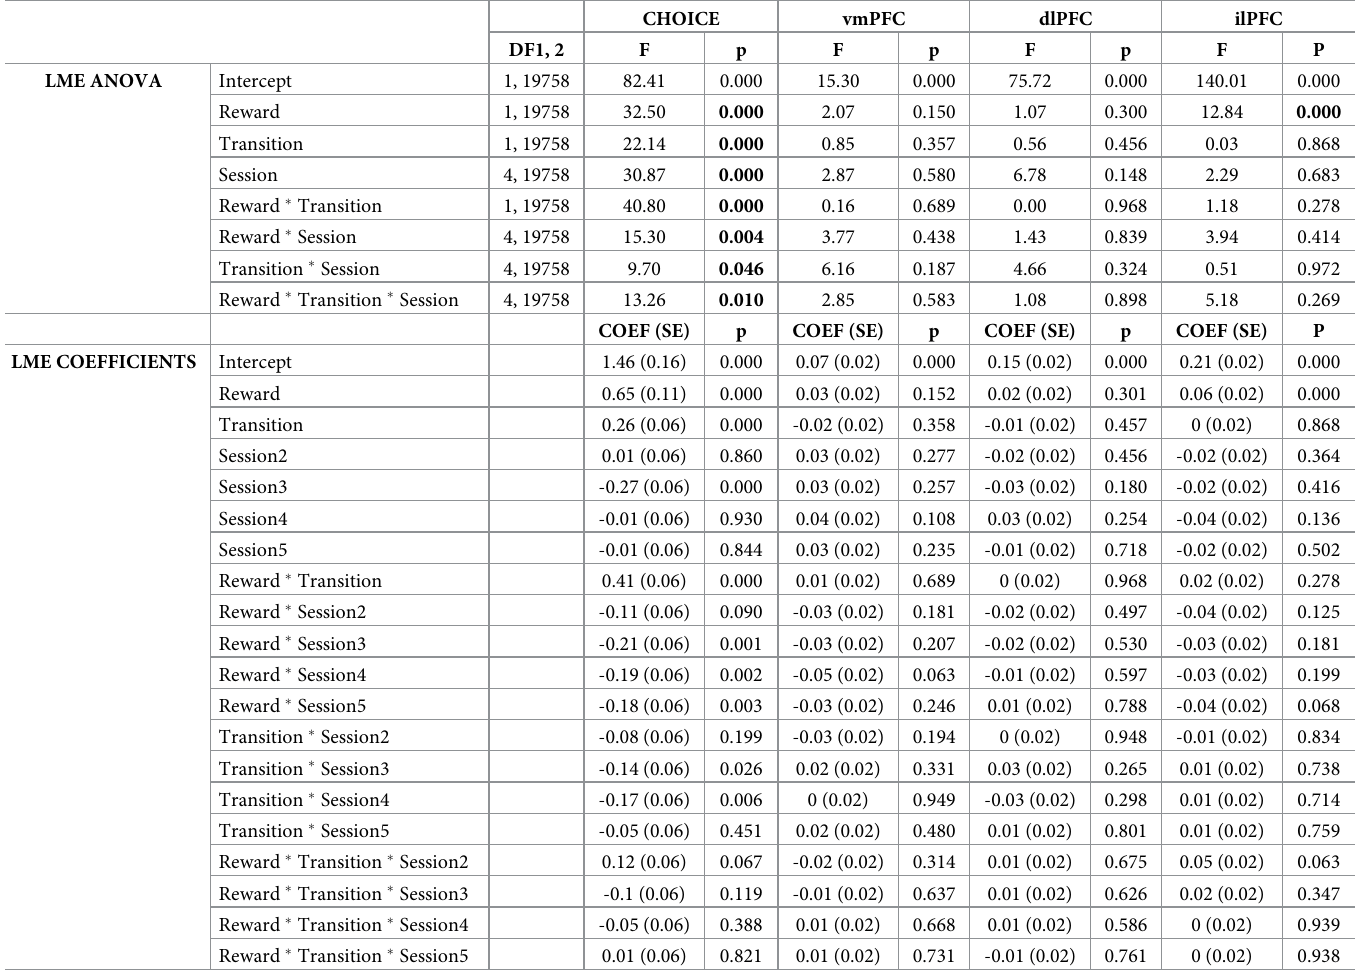
Table 2. LME. Top. ANOVA (F-stats and p-values) of the logistic and linear mixed-effects regression on behavioral choice, vmPFC, dlPFC and ilPFC. Degrees of freedom (DF). Bottom. LME coefficients (COEF with standard error, SE, and p-values) are shown in comparison with the reference session S1. For post-hoc comparisons see Fig 4